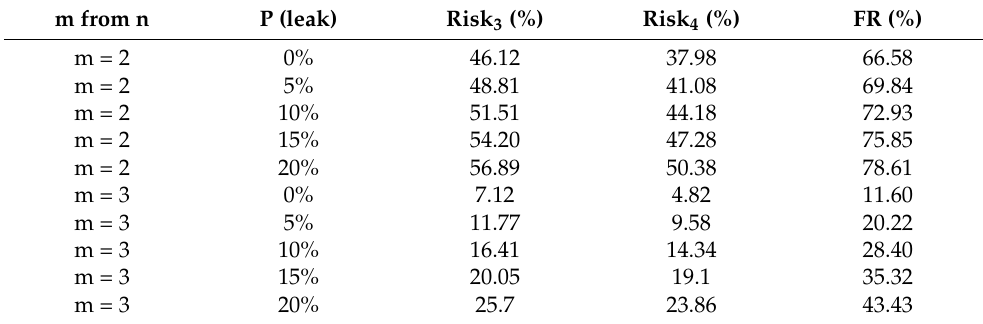
Table 3. The sensitivity analysis of the noise parameter and the structure “m from n” of start-up X.